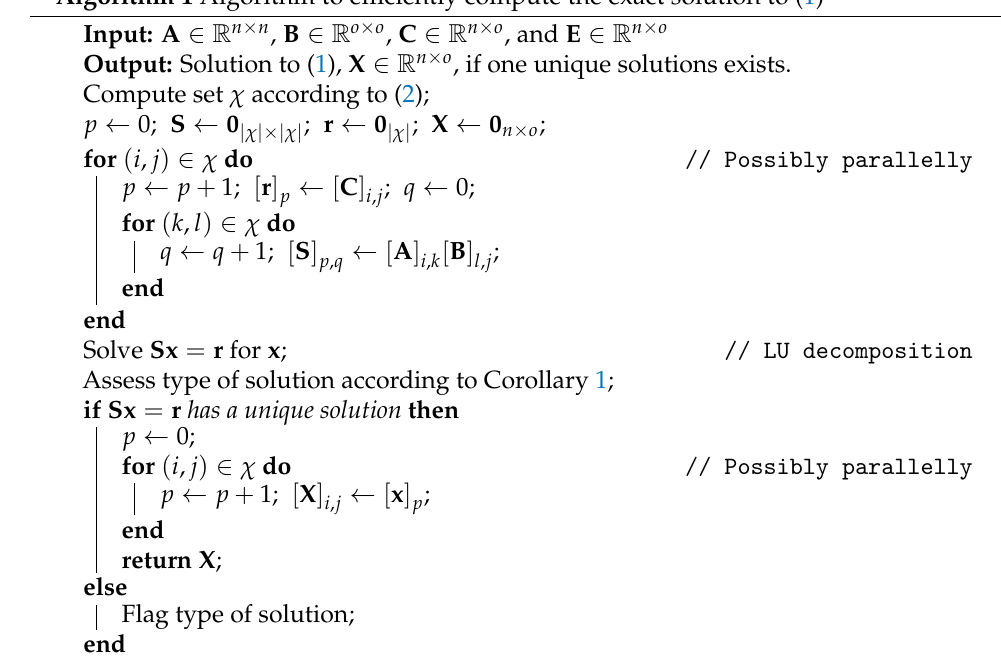
Algorithm 1 Algorithm to efficiently compute the exact solution to